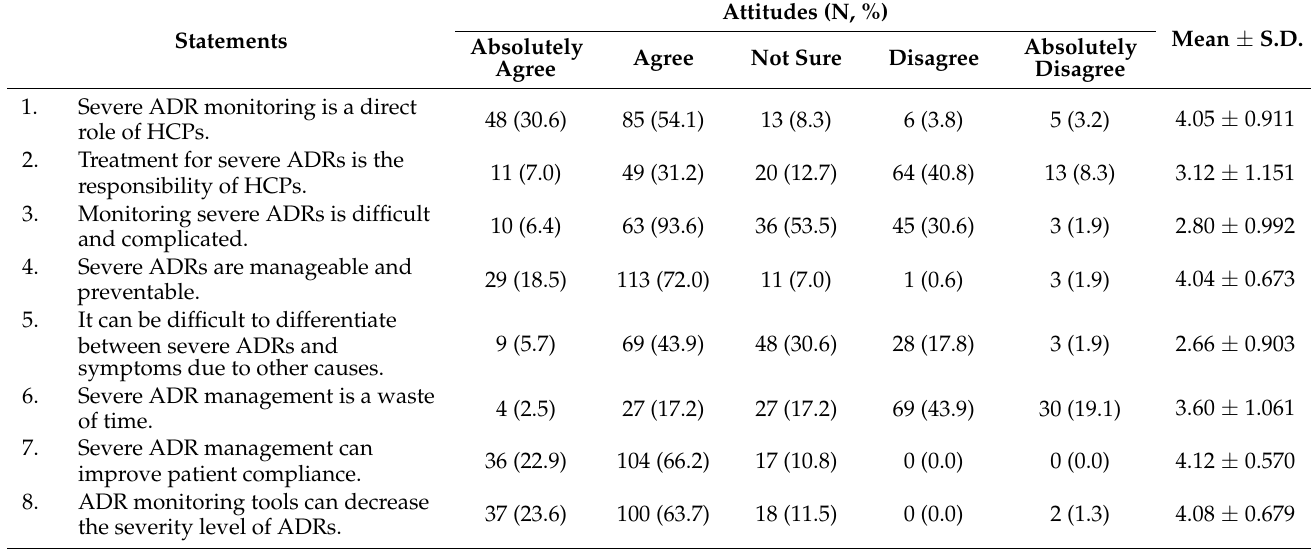
Table 5. Attitudes of respondents towards severe ADR